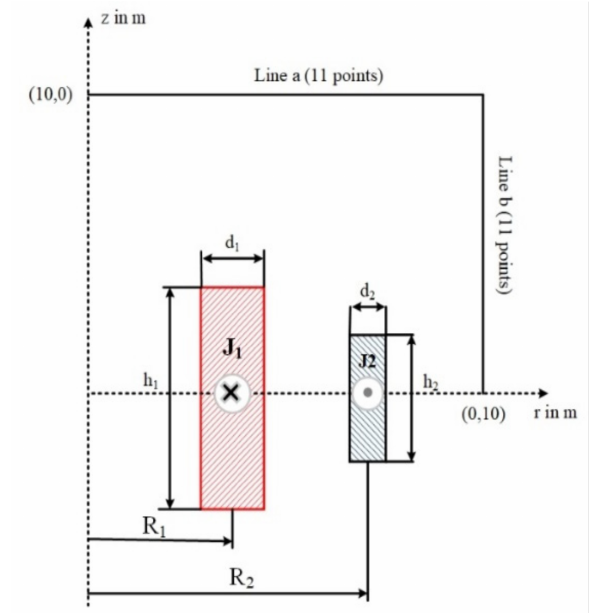
Figure 4. Schematic diagram of SMES